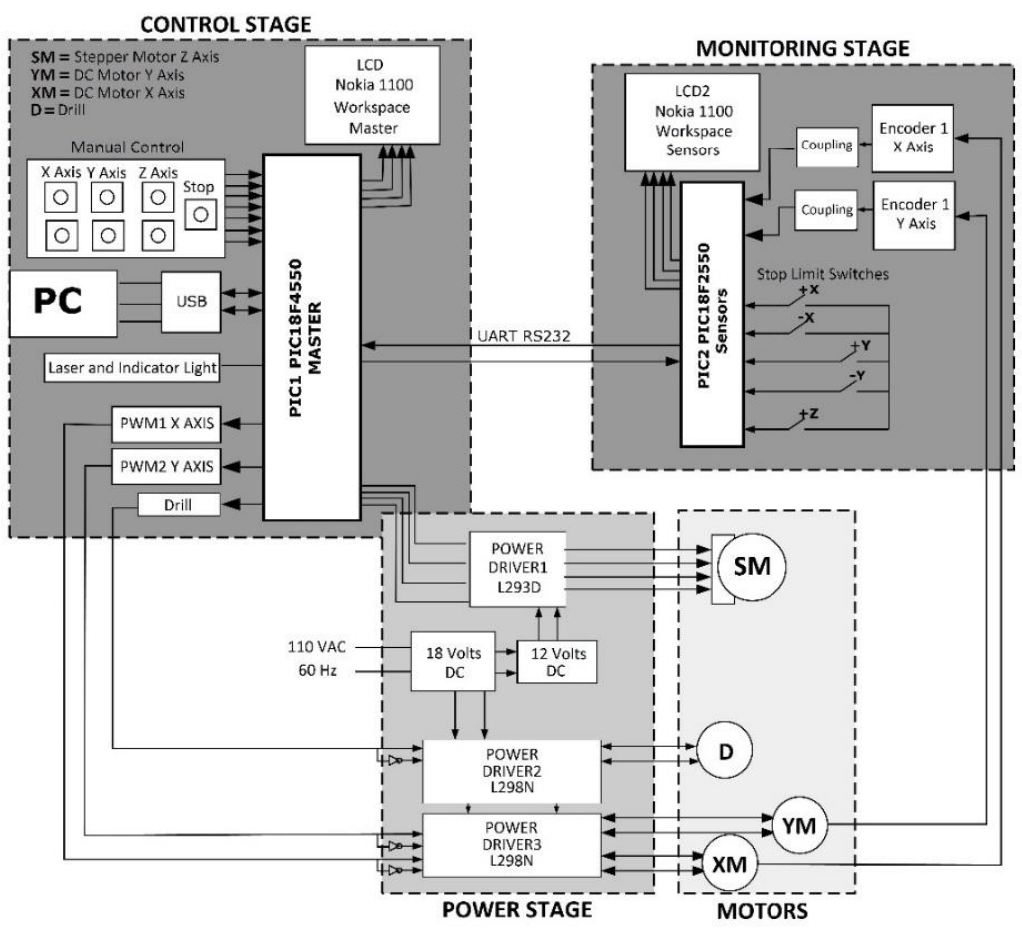
Figure 7. Block diagram of the prototype.